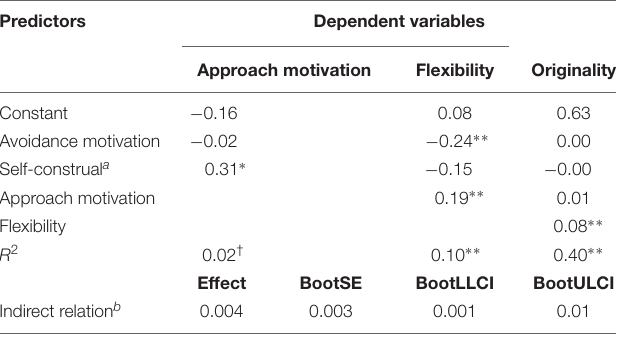
TABLE 2 | Study 1 regression results of the three-stage mediation